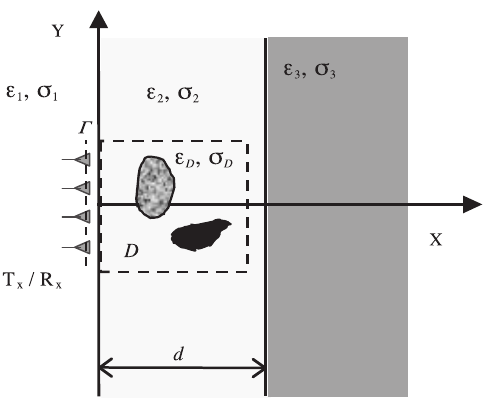
Fig. 1. Geometry of the